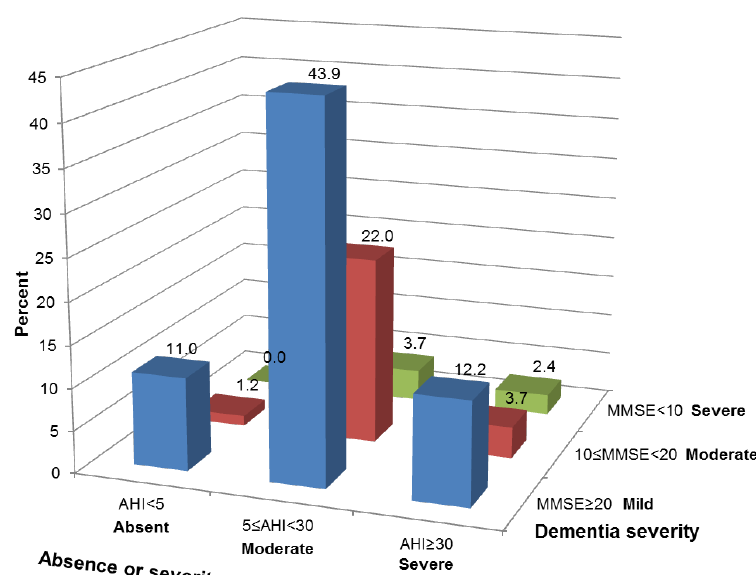
Figure A1. Association between severity of sleep-disordered breathing and severity of dementia. Chi-square test revealed no significant association χ²(4) = 4.67, p = 0.313, Cramer‘s V = 0.17. MMSE = Mini-Mental state examination.